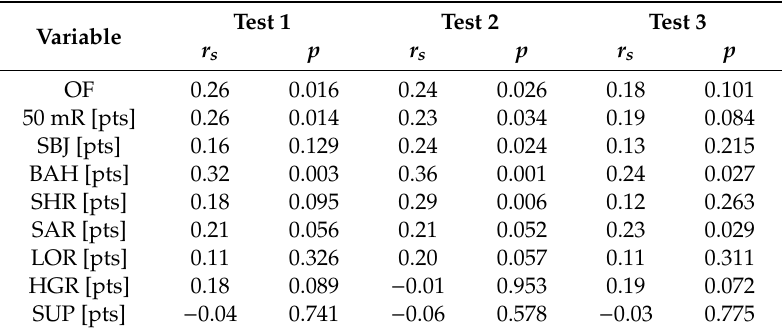
Table 4. Correlations between special and general physical fitness. Test 1 Test 2 Variable